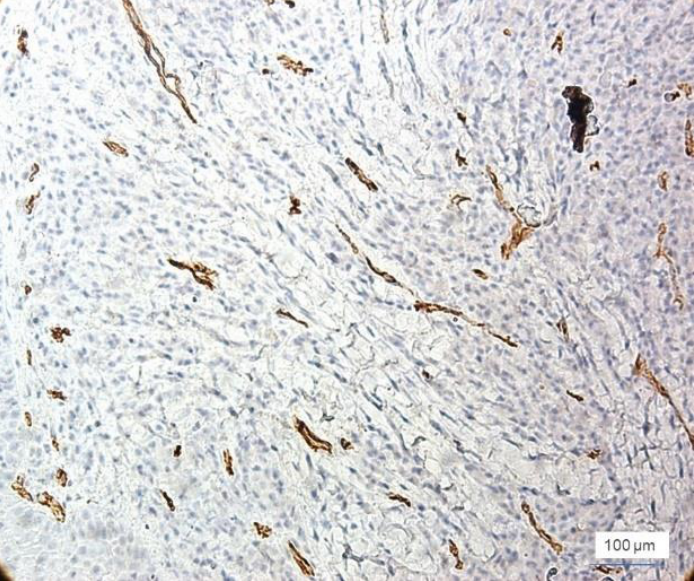
periodontal lesions. Thus, both small-caliber vessels with a very narrow lumen delimited by proliferative endothelial cells and small vessels without a lumen were observed (Figure 3).